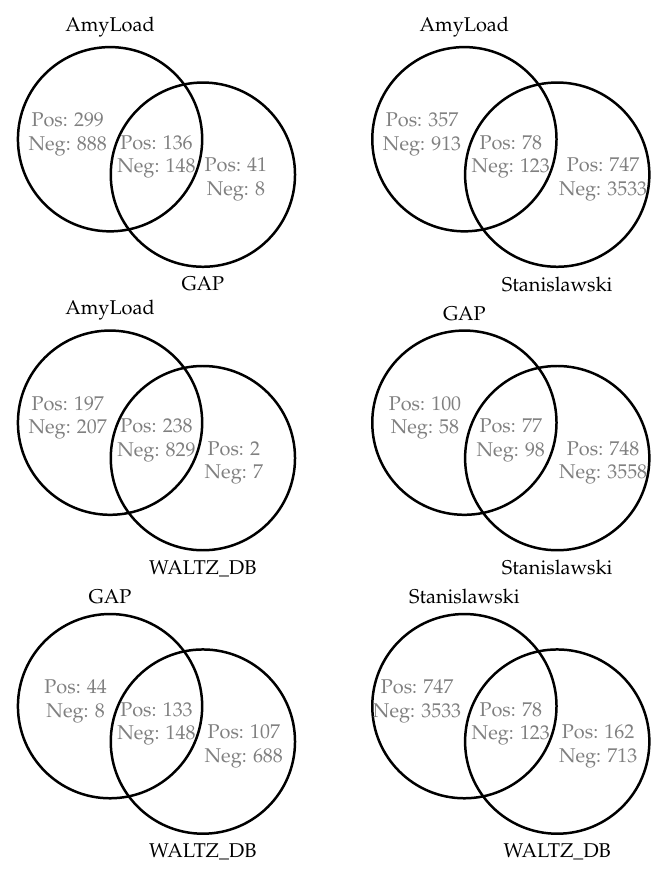
Figure 5. Combined amyloid databases used in work. Pos and Neg denote, respectively, positive and negative word counts in the